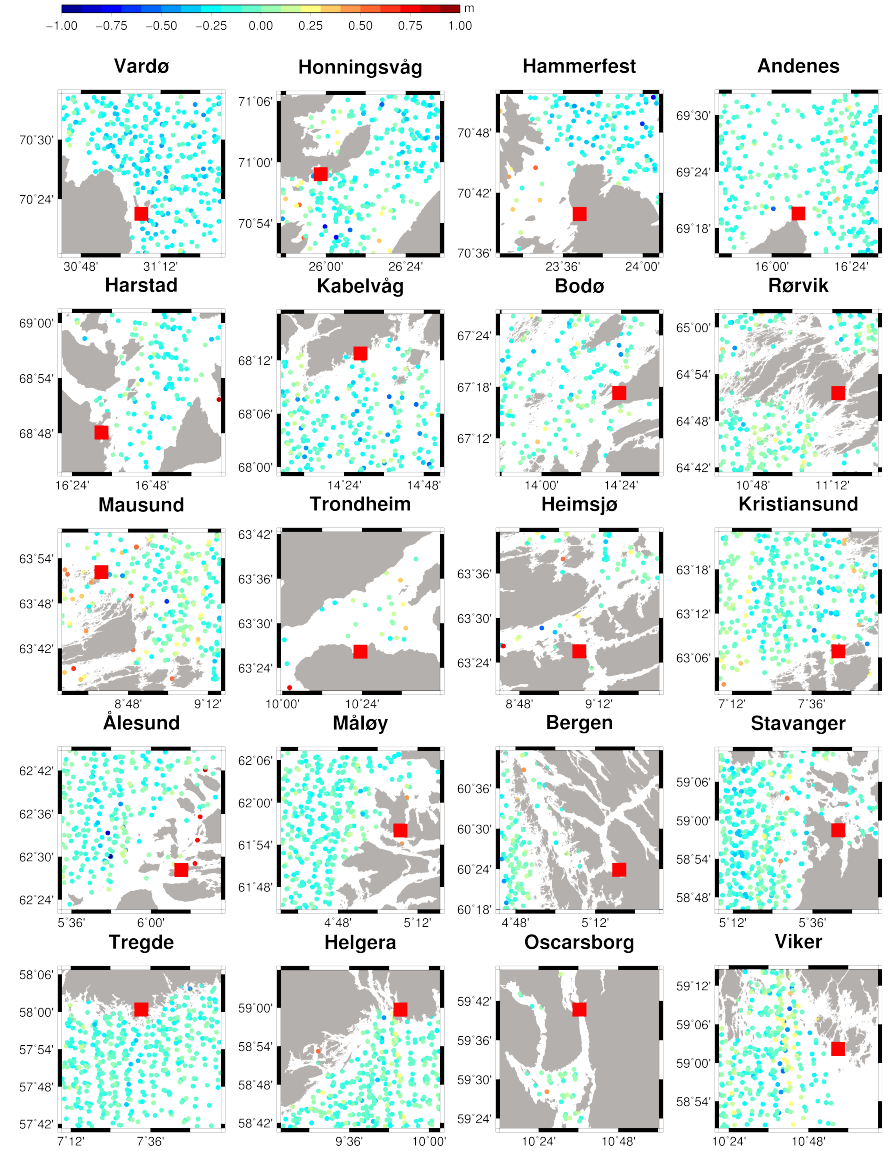
Figure 2. 1 Hz CS2 SARIn sea-level anomalies around 20 Norwegian tide gauges in 45 km × 45 km CS2 boxes. Red squares indicate the tide-gauge